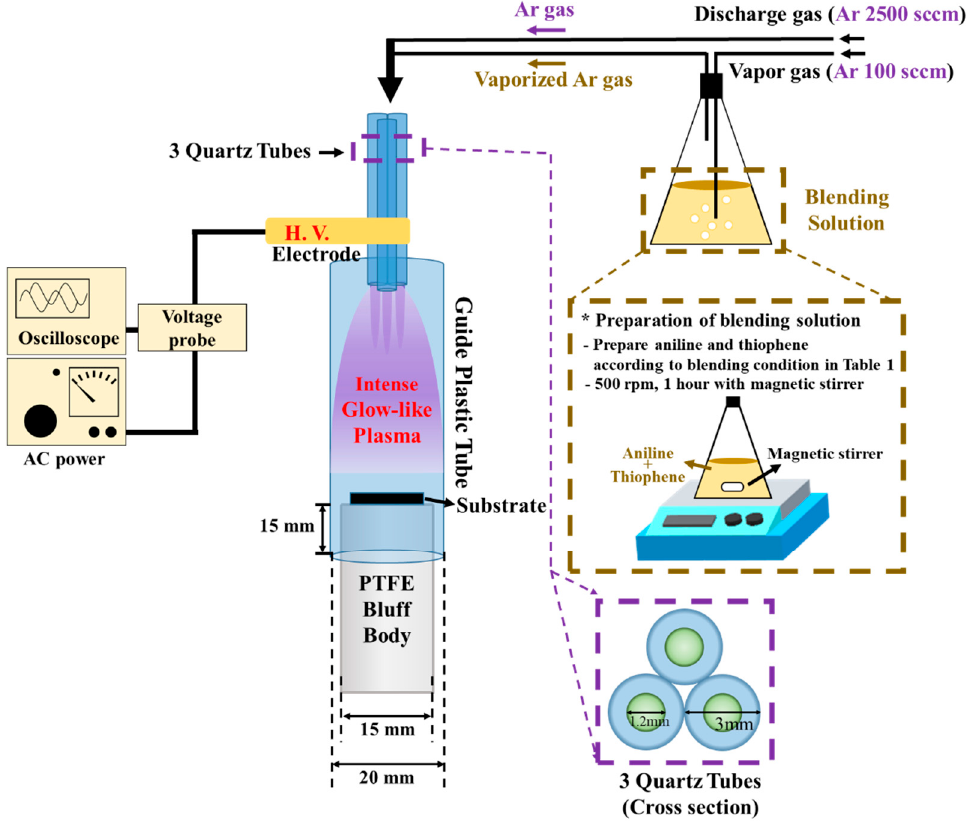
Figure 1. Schematic diagram of APPJs polymerization setup and preparation of blending solution employed in this study. Table 1. Blending ratios of aniline and thiophene monomers and deposition conditions of APPJs polymerization technique.